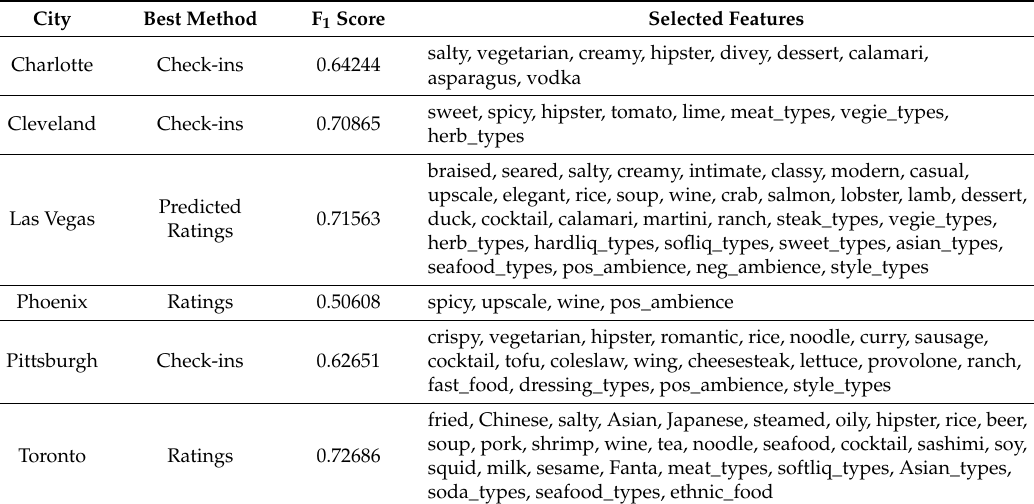
Figure 7. F 1 scores resulting from classification for different cities. Table 4. Selected features for different cities.